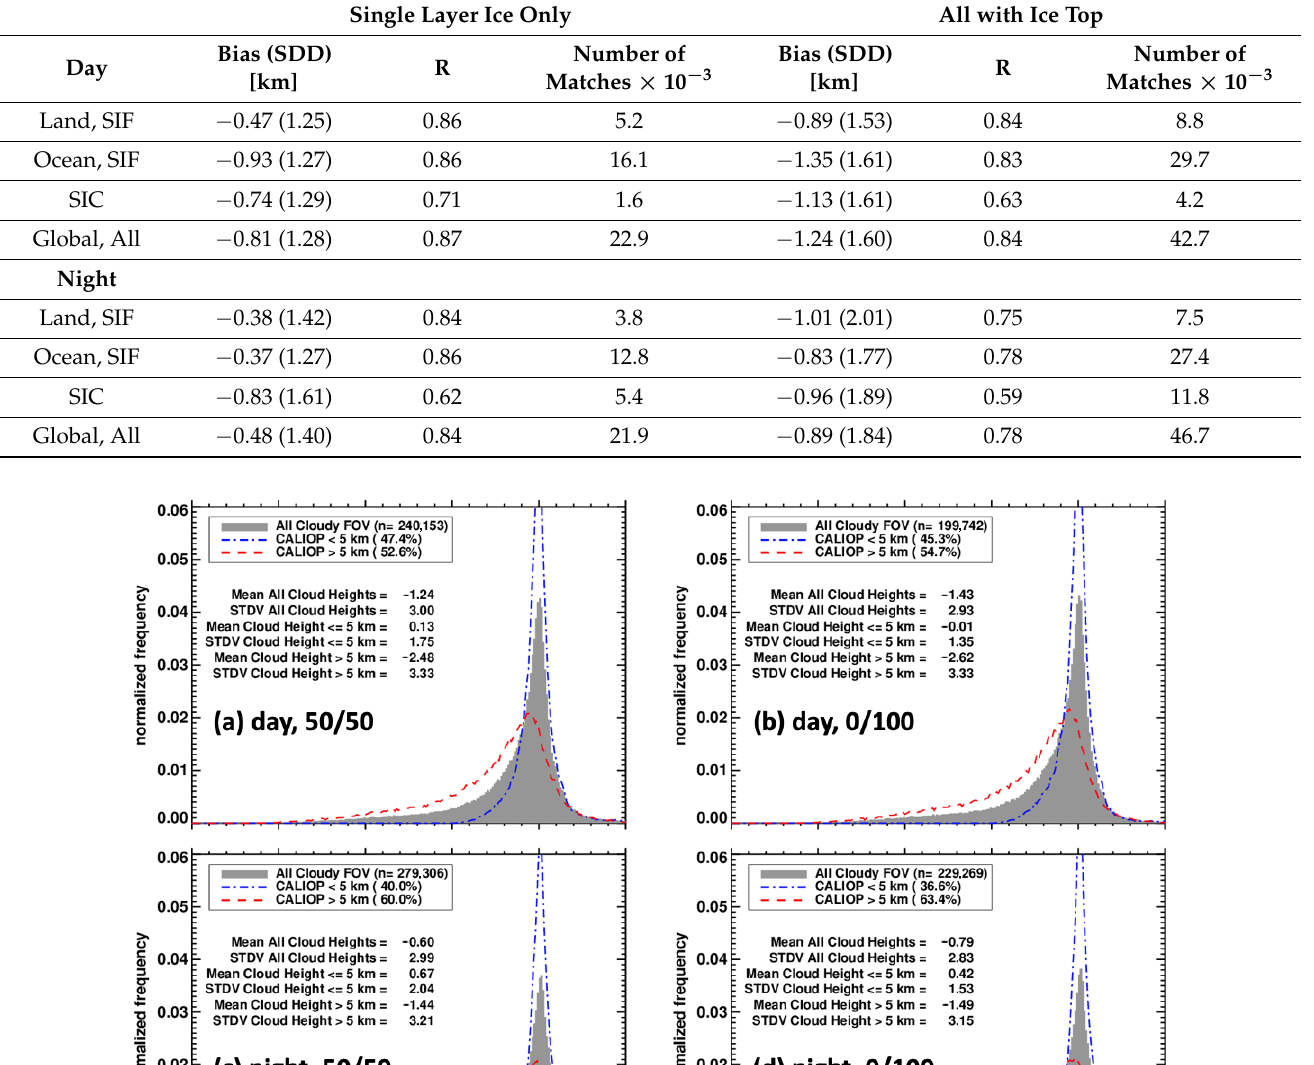
Table 6. Differences, SNPP VIIRS Ed1 − CALIPSO, cloud top heights for opaque ice clouds, JAJO